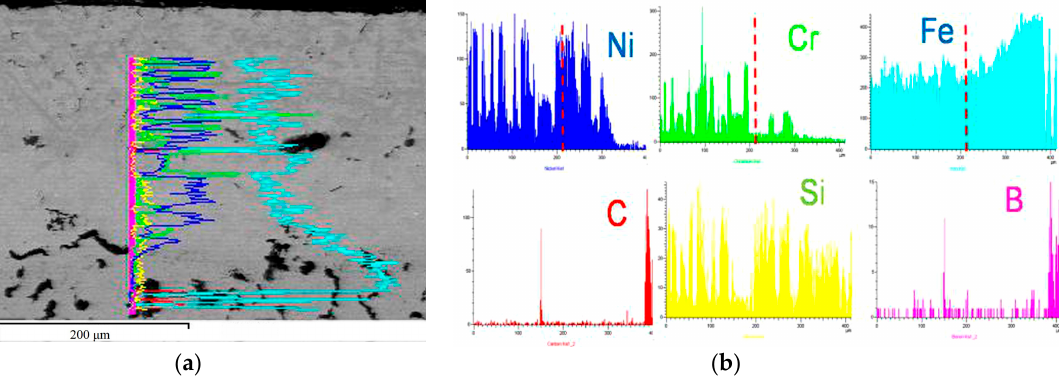
Figure 7. EDS element analysis of the Ni60 coating annealed at 990 °C for twenty minutes: ( a ) line analysis of elements; ( b ) element distribution along the line.